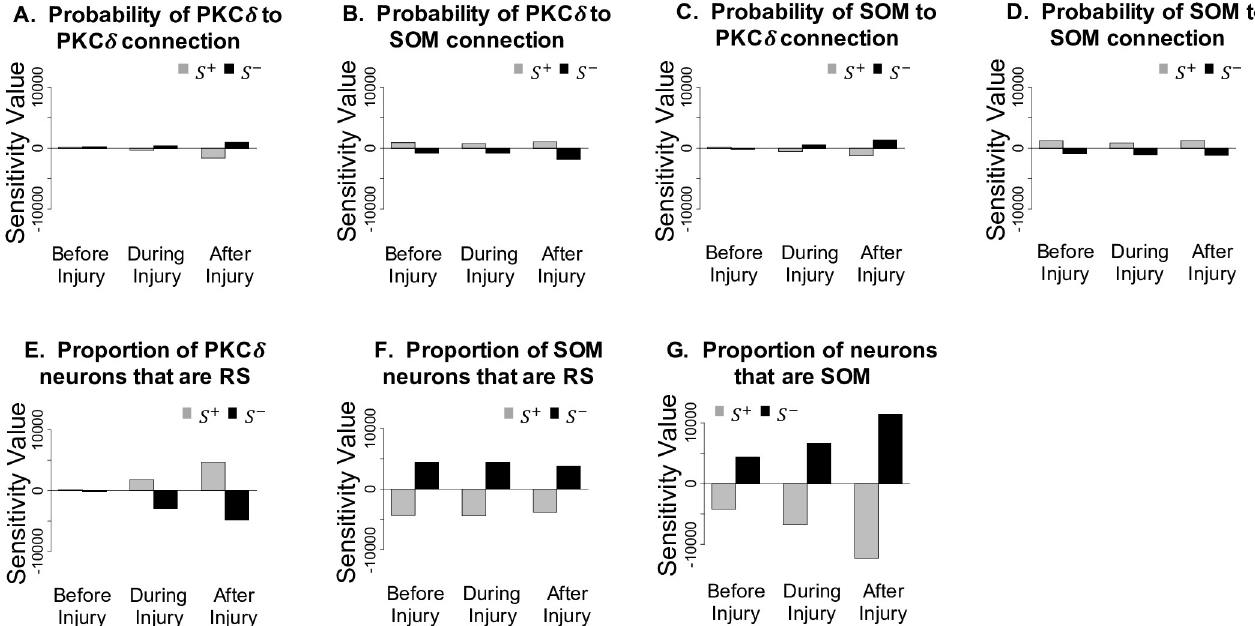
Fig 5. Sensitivity analysis of 50:50 model. A sensitivity analysis was conducted on the 50:50 model with constant 120 pA current to determine the sensitivity of pain output to select model parameters before injury (t = 10), during injury (t = 105), and after injury (t = 240). Values of S + and S − represent the sensitivity of pain to small increases and decreases, respectively, in each parameter. Relatively small values of S + and S − are associated with the connectivity parameters ( A-D ). The larger sensitivity values associated with the parameters determining the proportion of PKC δ neurons that are regular spiking ( E ), the proportion of SOM neurons that are regular spiking ( F ), and the proportion of neurons that are SOM ( G ) indicate pain is most sensitive to perturbation in these parameters.